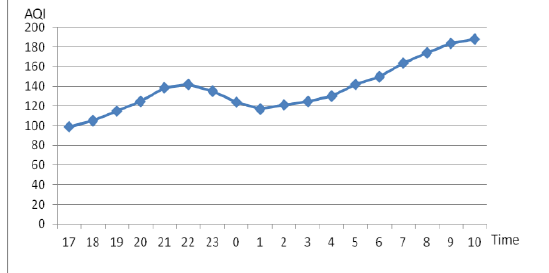
Fig.2 AQI Trend Map of State Control Points in Hefei from 17:00 on February 8, 2018 to 10:00 on February 9, 2018 Fig.3 Inversion Chart of Navigation Monitoring at 10:05 on February 10, 2018 in Hefei